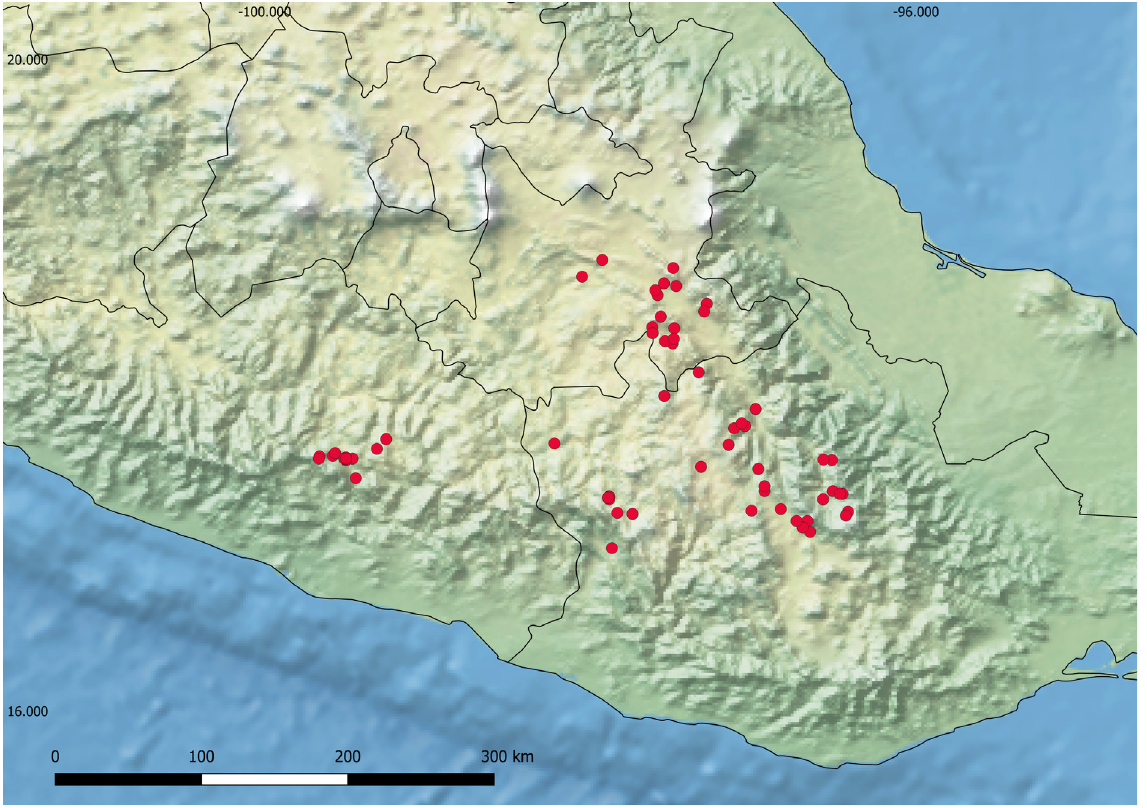
Fig. 10. Locality records of Salvadora intermedia Hartweg,